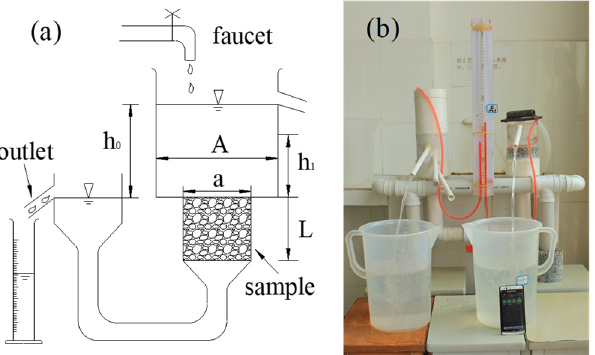
Figure 2. The instrument for measuring the permeability of the pervious concrete samples: ( a ) schematic outline; ( b ) laboratory setup.